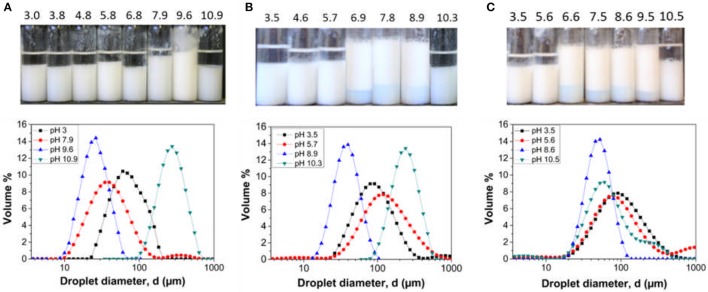
Hexadecane in water emulsions stabilized by (A) LP-DMAEMA54, (B) LP-DMAEMA108 and (C) LP-DMAEMA245 as a function of pH. Digital micrographs of the emulsions 24 h after production (top) and the droplet diameter distribution based on volume % (bottom). No background electrolyte was added to the continuous phase and measurements were performed a 25°C.